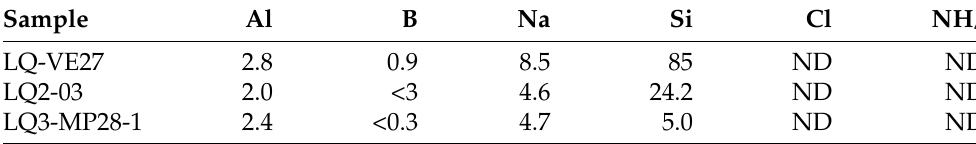
Table 3. Measured concentrations in µgL − 1 of clean feed-water